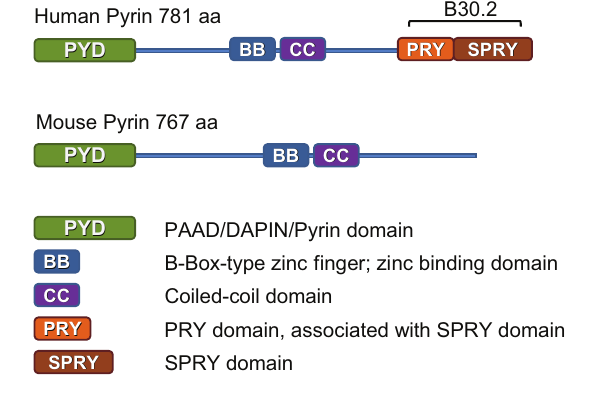
FIgure 1 | Differences between pyrin in human and